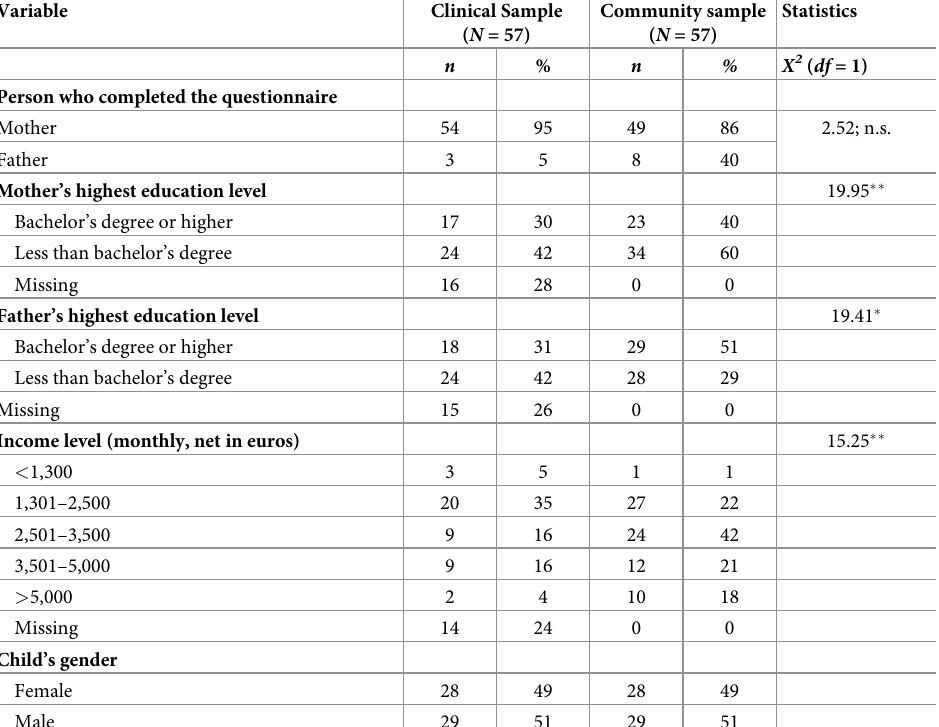
Table 3. Sociodemographic data of the parents of the matched Clinical Sample (ClinS) and the Community Sam- ple (ComS).